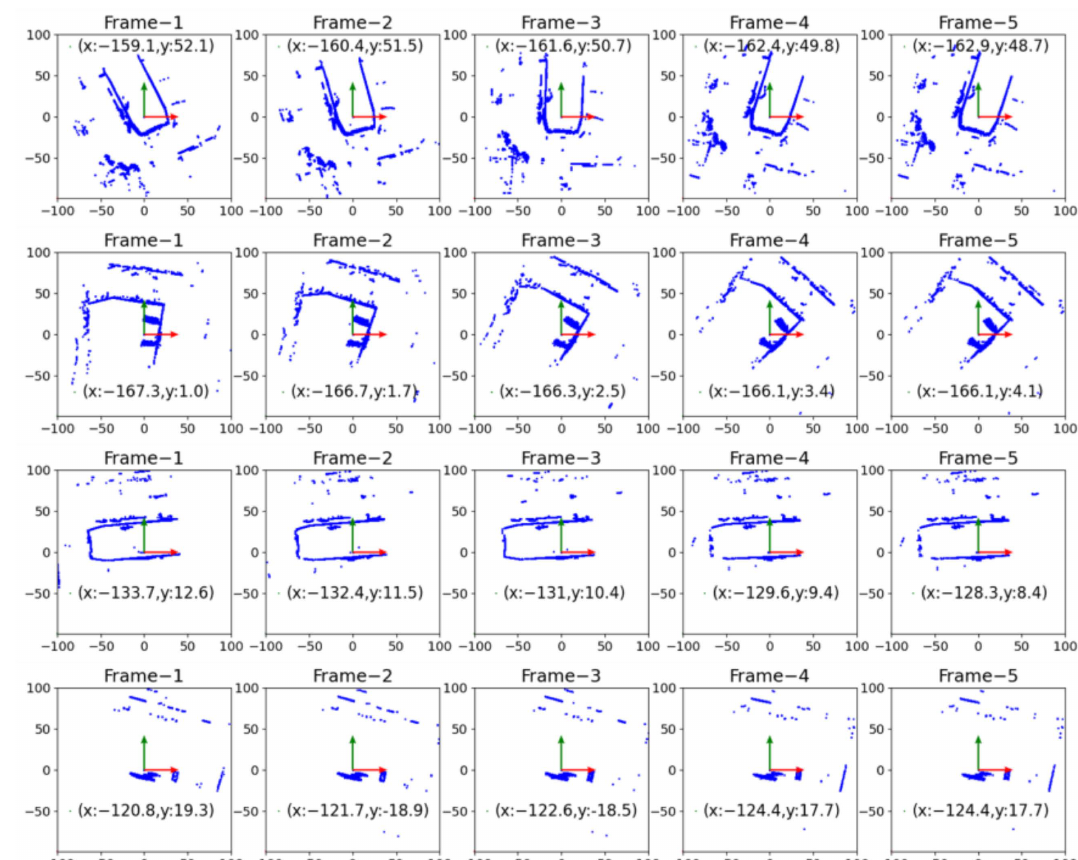
Figure 8. Top view of ASV point cloud in different